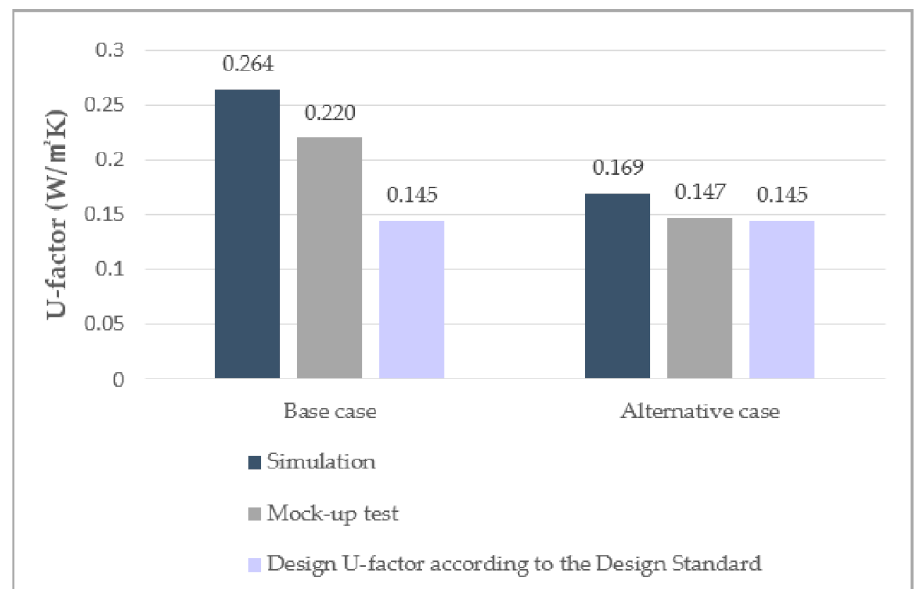
Figure 15. U-factor evaluation